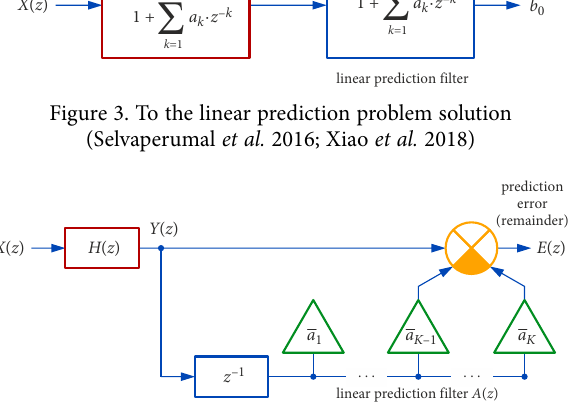
Figure 4. The structure chart of the system with the